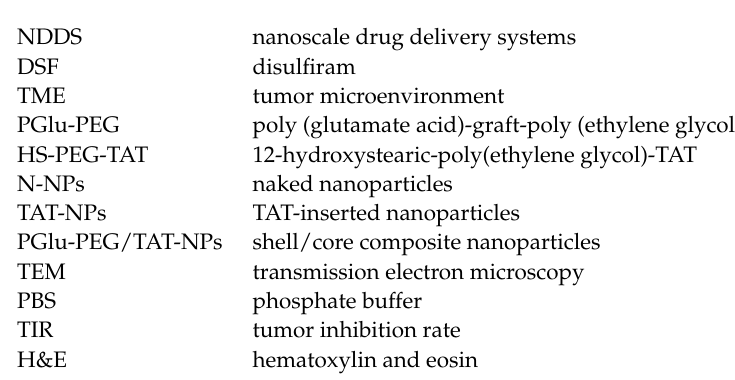
Figure S4. Changes in zeta potential of DSF-loaded N-NPs, TAT-NPs, PGlu-PEG/TAT-NPs with 2%, 5% and 10% PGlu-PEG coating in pH 7.4 PBS during 24